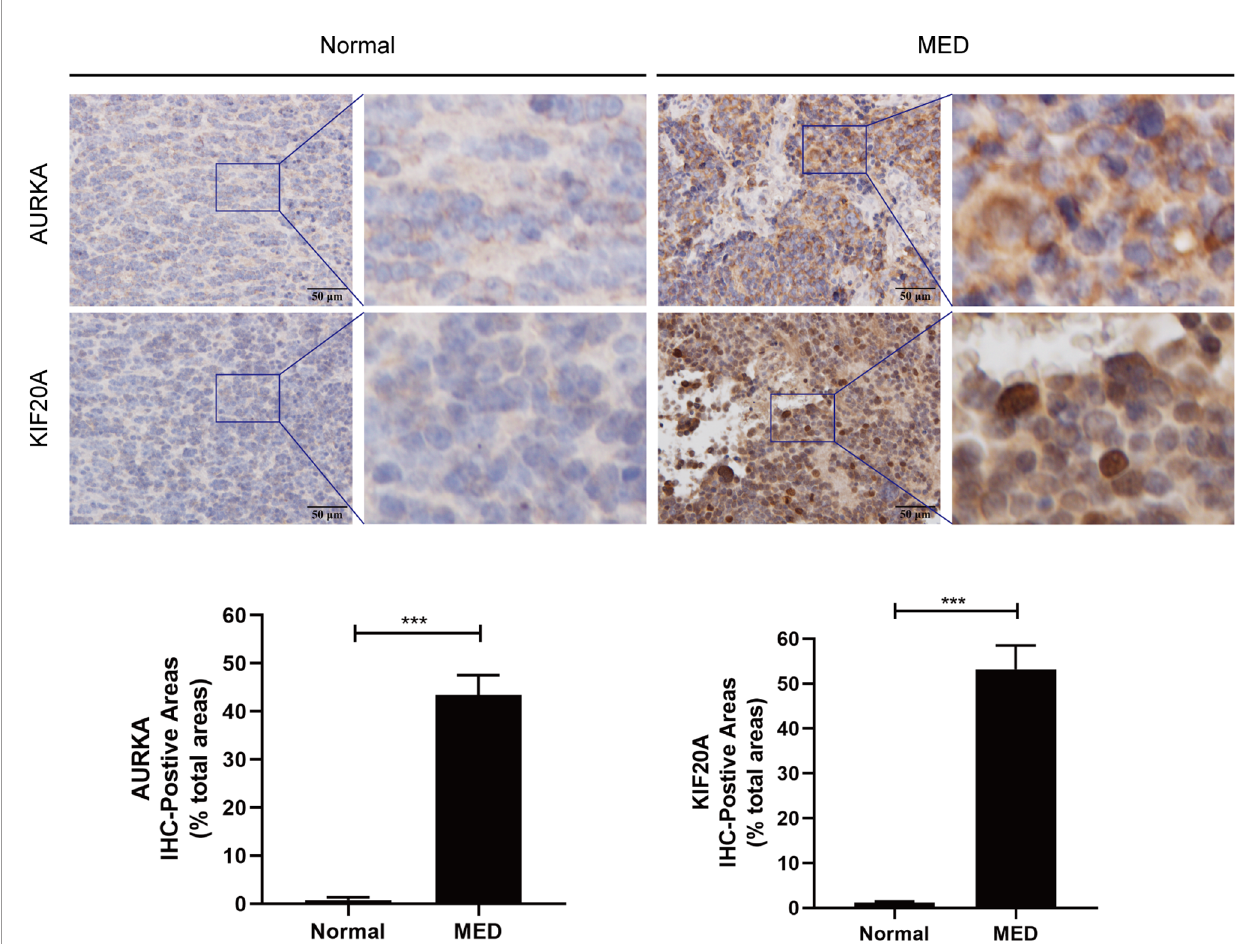
FIGURE 9 | Immunohistochemistry analysis of AURKA and KIF20A expression in Medulloblastoma tissues from Tianjin Huanhu Hospital (normal brain, n = 4; MED, n = 10). Scale bar = 50 m m. Below is a list of statistical quantitative analyses. Data are mean ± SD. ***P < 0.001, one-way